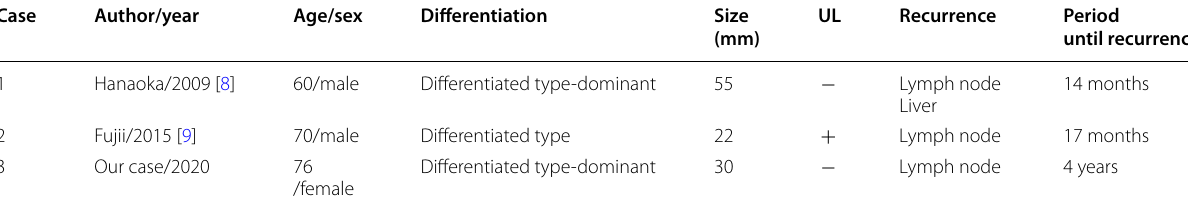
Only 2 previous case reports were reported a recurrence after the eCuraA ESD